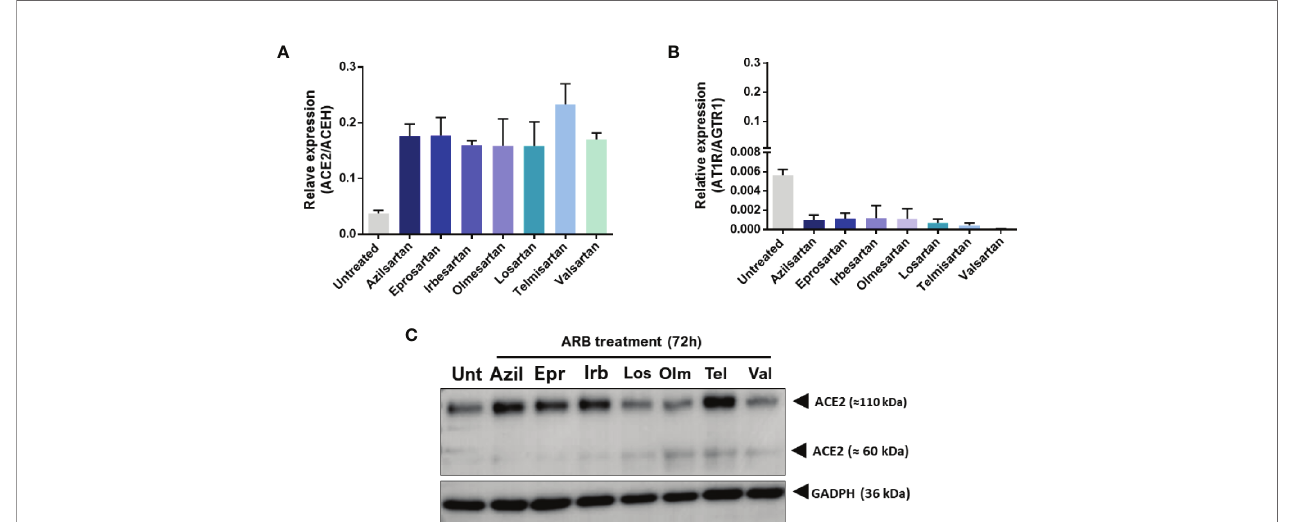
FIGURE 1 | Expression of Angiotensin II receptor type 1 (AT1R) and Angiotensin-converting enzyme 2 (ACE2) mRNAs and proteins by VERO E6 cells following 72 hours incubation with different Angiotensin II Receptor Blockers (ARBs). Non-cytotoxic concentrations of ARBs (Azil, Azilsartan 15µM; Epr, Eprosartan 30µM; Irb, Irbesartan 60µM; Los, losartan 7µM; Olm, Olmesartan 15µM; Tel, Telmisartan 7µM; Val, Valsartan 7µM) were previously de fi ned by the MTT assay and cells were treated with the various ARBs. (A) Relative expression of the ACE2/ACEH gene in untreated (Unt) and ARB-treated Vero E6 cells. (B) Relative expression of the ATR1/AGTR1 gene in untreated versus ARB-treated Vero E6 cells. (C) Expression of ACE2 protein in untreated versus ARB-treated Vero E6 cells (the membrane- anchored ACE2 glycosylated protein that acts as receptor for SARS-CoV-2 is the 110kDa form of the molecule).